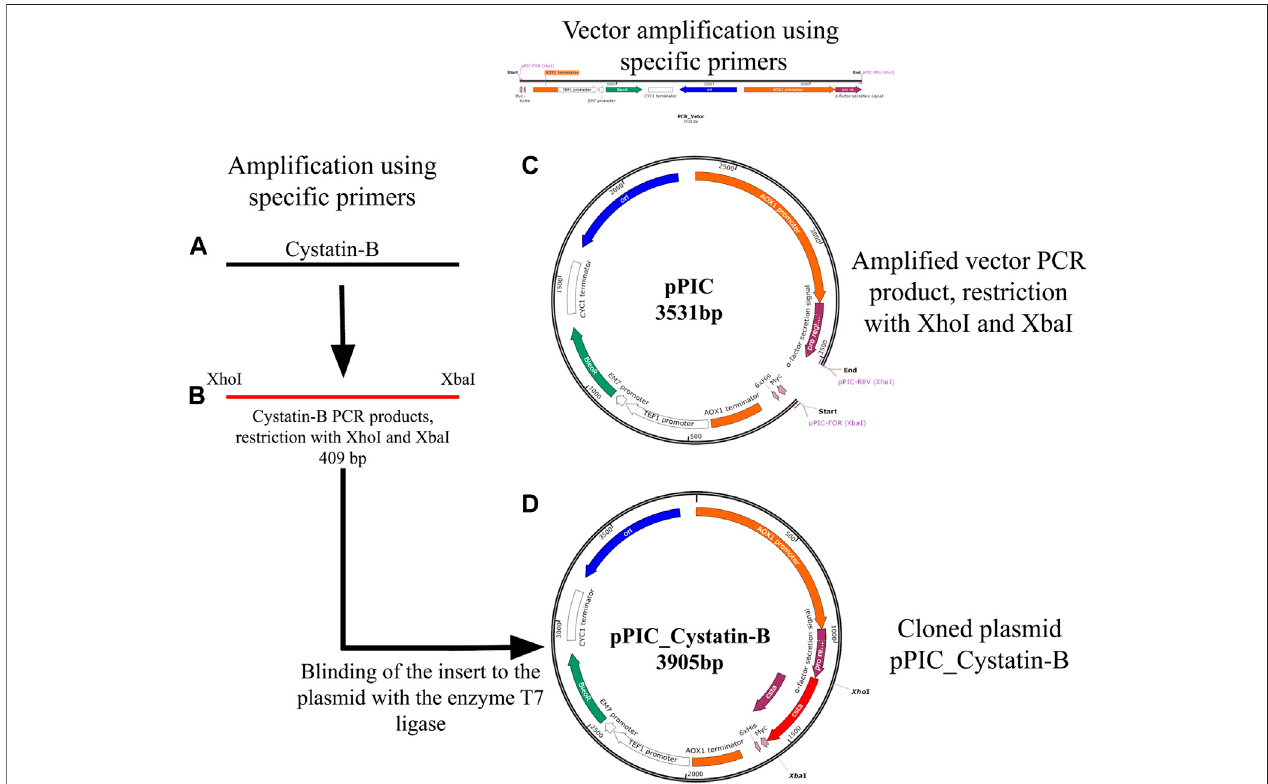
FIGURE 1 | Schematic representation of the genetic construct containing cystatin-B (A) Ampli fi cation by PCR of the cystatin-B gene of juveniles of Pygocentrus nattereri ,usingspeci fi cprimers,designedbasedonthesequenceXM_017717432. (B) Ampli fi edPCRproductsandcleavedwithXhoIandXbaIenzymes. (C) .Ampli fi ed vector (pPIC) products by PCR, cleaved with XhoI and XbaI. (D) . Cloned plasmid pPIC_Cystatin-B (Binding of the insert to the plasmid with the enzyme T7